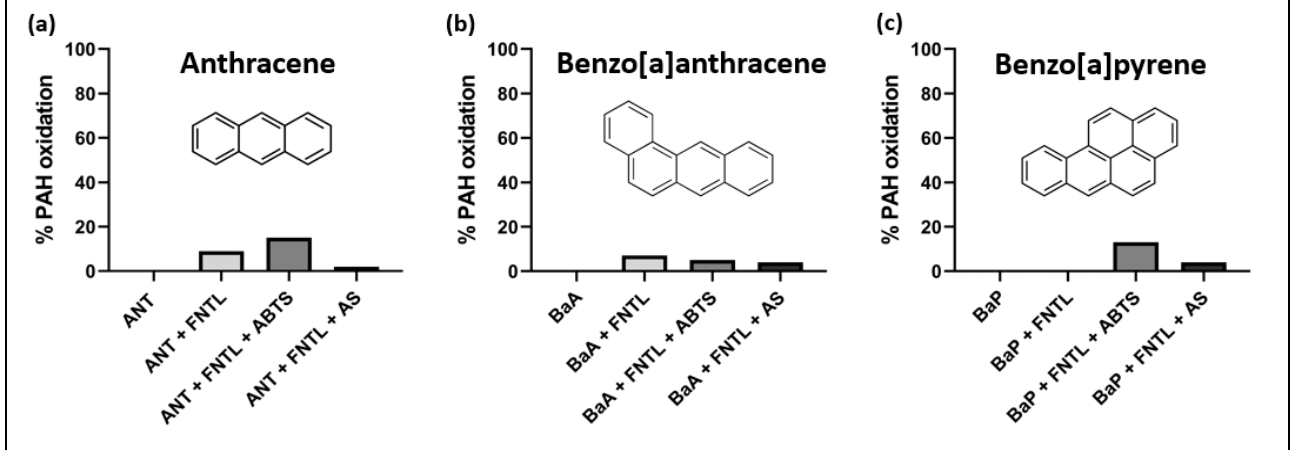
Figure 3. Oxidation of di ff erent PAHs in the presence of FNTL. ( a ) ANT, ( b ) BaA, and ( c ) BaP, each at 0.025 mg mL − 1 , were exposed to partially puri fi ed FNTL (0.1 mg mL − 1 ) in aqueous solution. The e ff ect of 1 mM redox mediators ABTS and AS, was also evaluated. Reactions were incubated for 7 days at 30 °C with shaking at 150 rev min − 1 , with enzyme re fi ll at the 3 rd day.